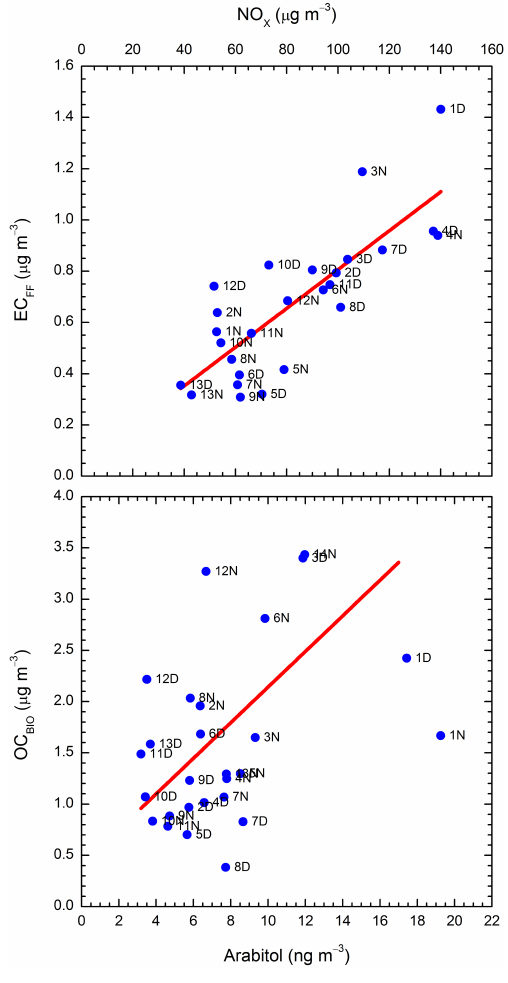
Figure 7. Scatter plots between apportioned atmospheric concentra- tions of EC FF and OC BB , and of OC BB and air temperature ( T ) for the PM 2 . 5 size fraction in central Budapest. The red lines represent a linear fit to the data. The order number of the samples together with daylight time (D) or night (N) periods is indicated by labels next to the data points.